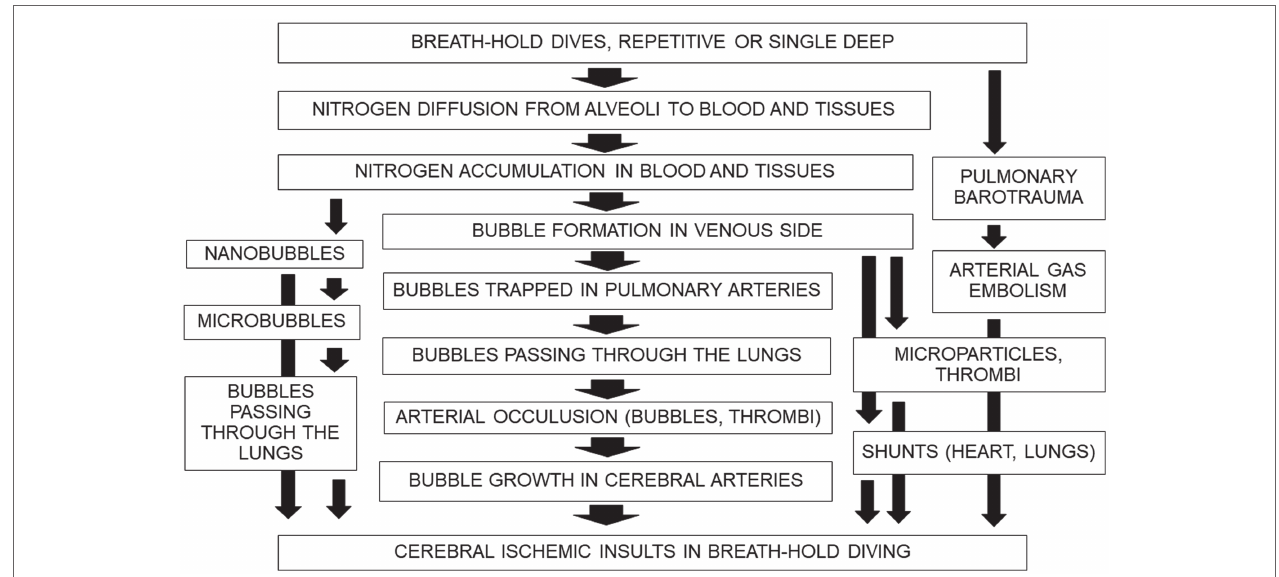
( Figure 4 ) may explain why cerebral DCI in BH dives, its clinical course, and neuroimaging